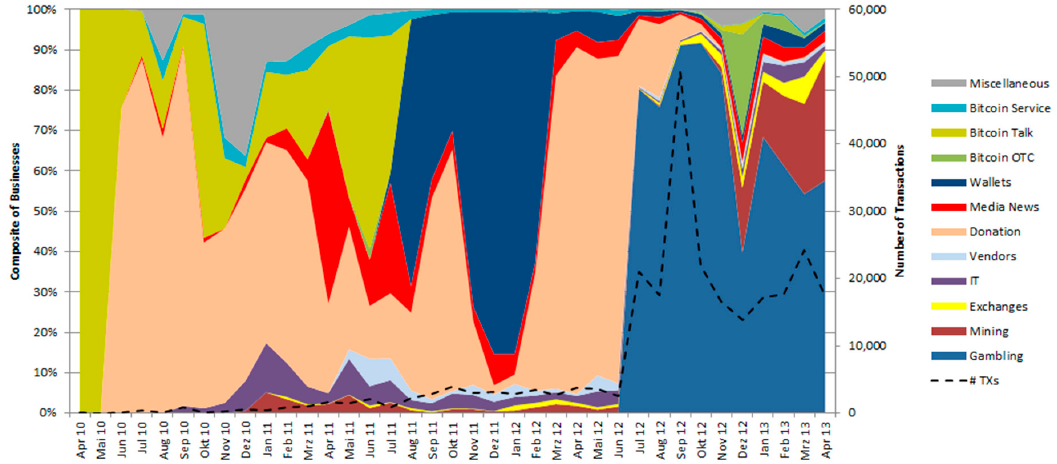
Figure 10. Composite of Businesses over Time (in Terms of Number of Transactions, #TXs).